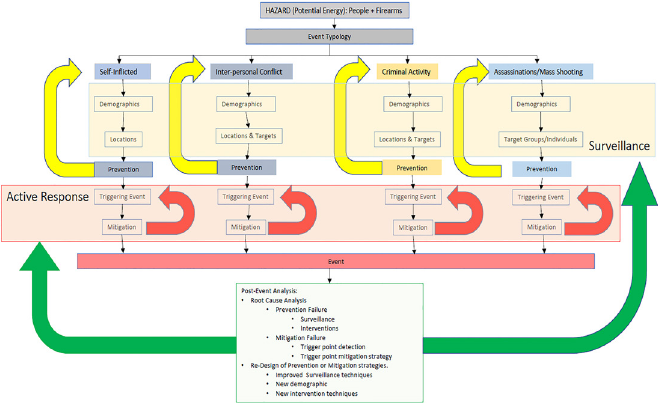
Figure 2. A notional Utstein framework to reduce firearm